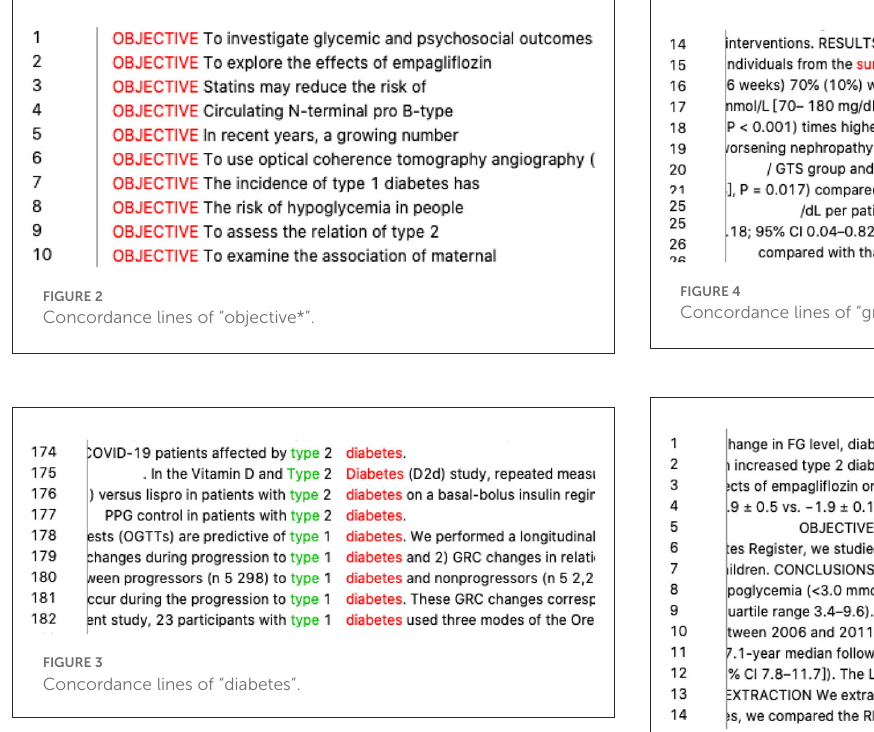
FIGURE5 Concordance lines of